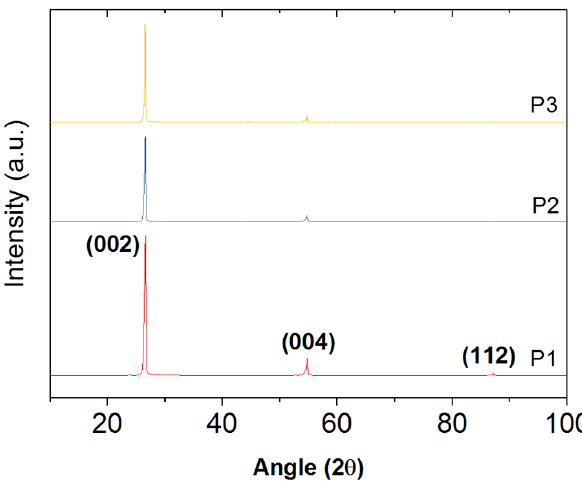
Figure 3: X-ray diffraction patterns of the NGF.